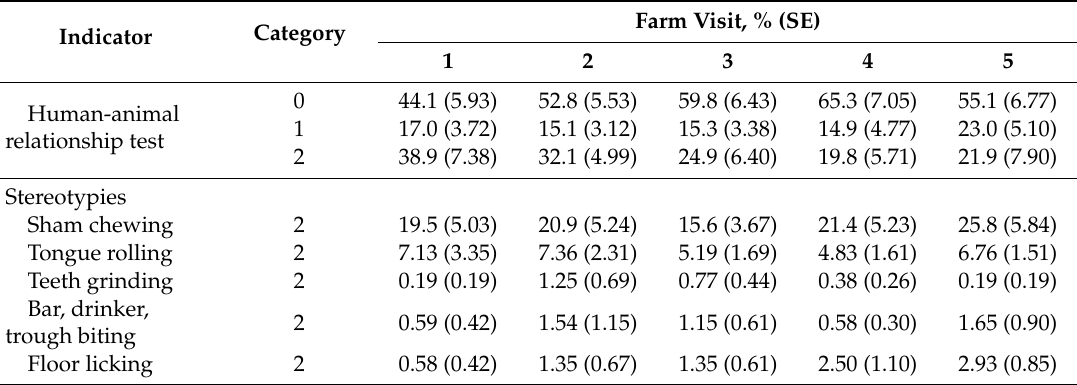
Table 8. Mean values (%) and standard errors (SE) of the five farm visits (1–5) for the categories of the human − animal relationship test and the categories of the assessment of